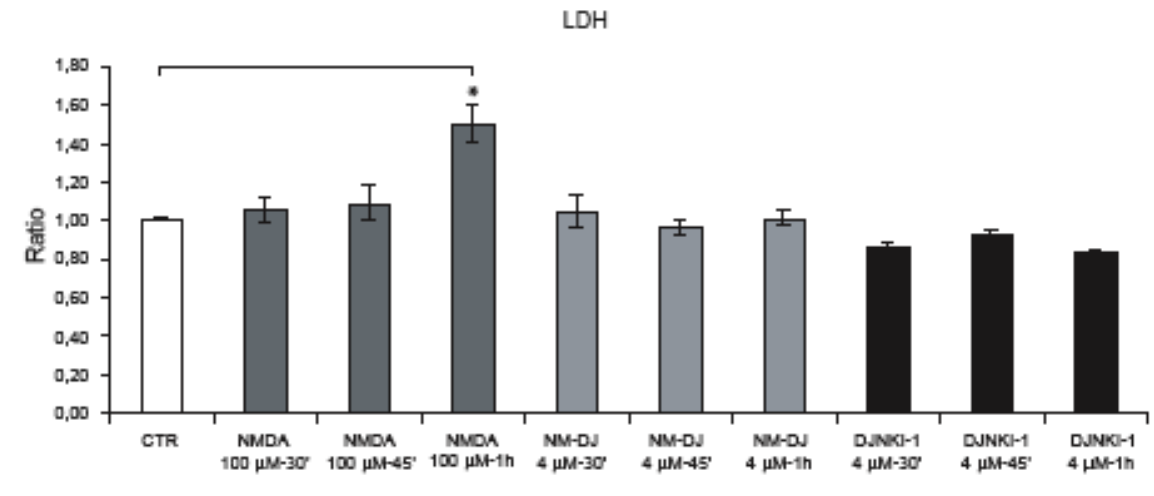
Figure 6. Neurons were exposed to NMDA (30’-45’-1 h) and neuronal viability was assessed by LDH assay. Application of D-JNKI alone or in combination with NMDA (30’-45’) did not affect neuronal survival. NMDA for 1 h significantly increased neuronal death while treatment with D-JNKI protected neurons. Quantification is from five independent experiments ( ± SEM), ( ∗ p <